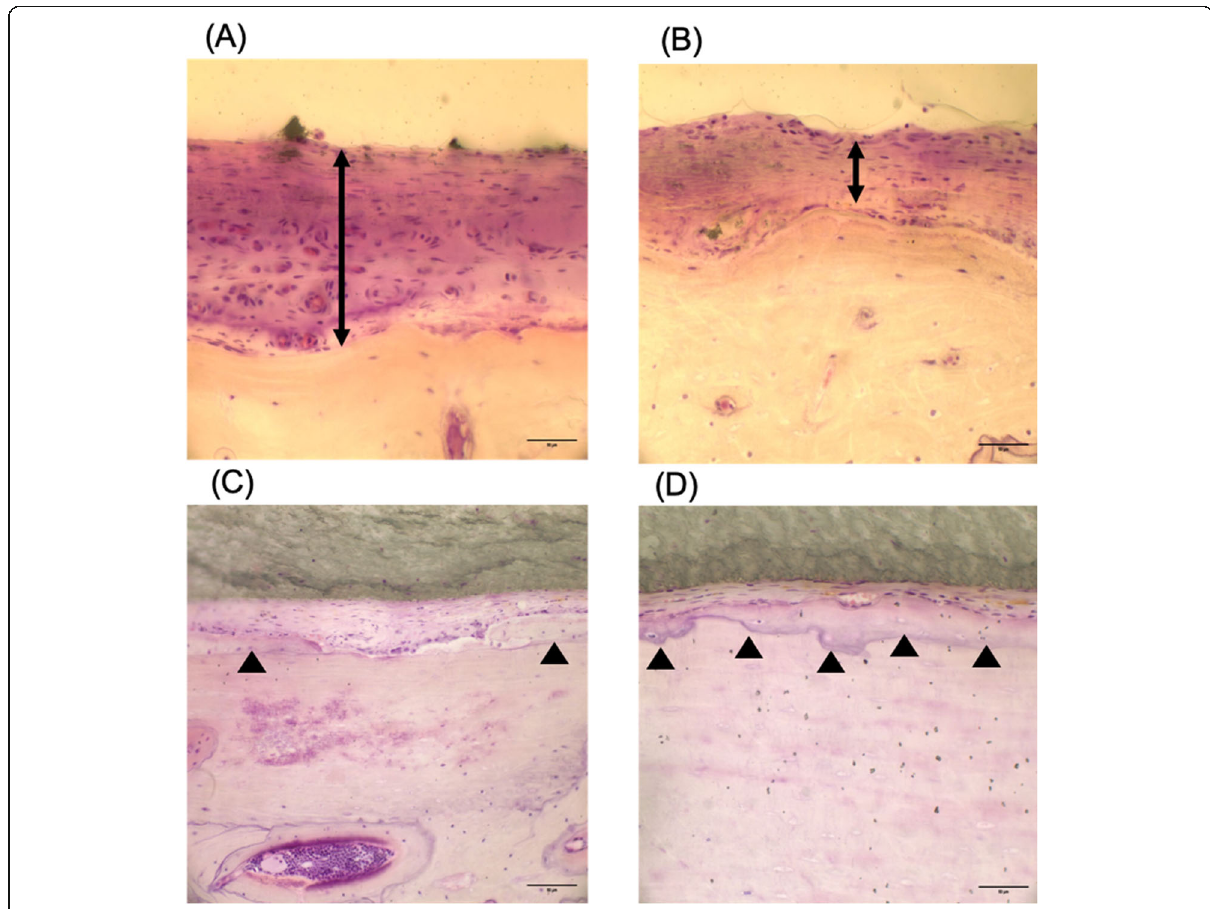
Fig. 3 Photomicrographs of the histological slides. Photomicrographs of the histological slides showing biological responses toward Ta-treated and untreated facial implants. a Untreated silicone implant material and b Ta-treated silicone implant material. The two-headed arrows in a and b indicate the soft tissue thickness between the implant material and the bone at 8-week intervals. c Untreated ePTFE implant and d treated ePTFE implant material. The upwards filled arrows in c and d indicate newly formed bone between the implant material and the bone at 4-week intervals (H&E stain, ×